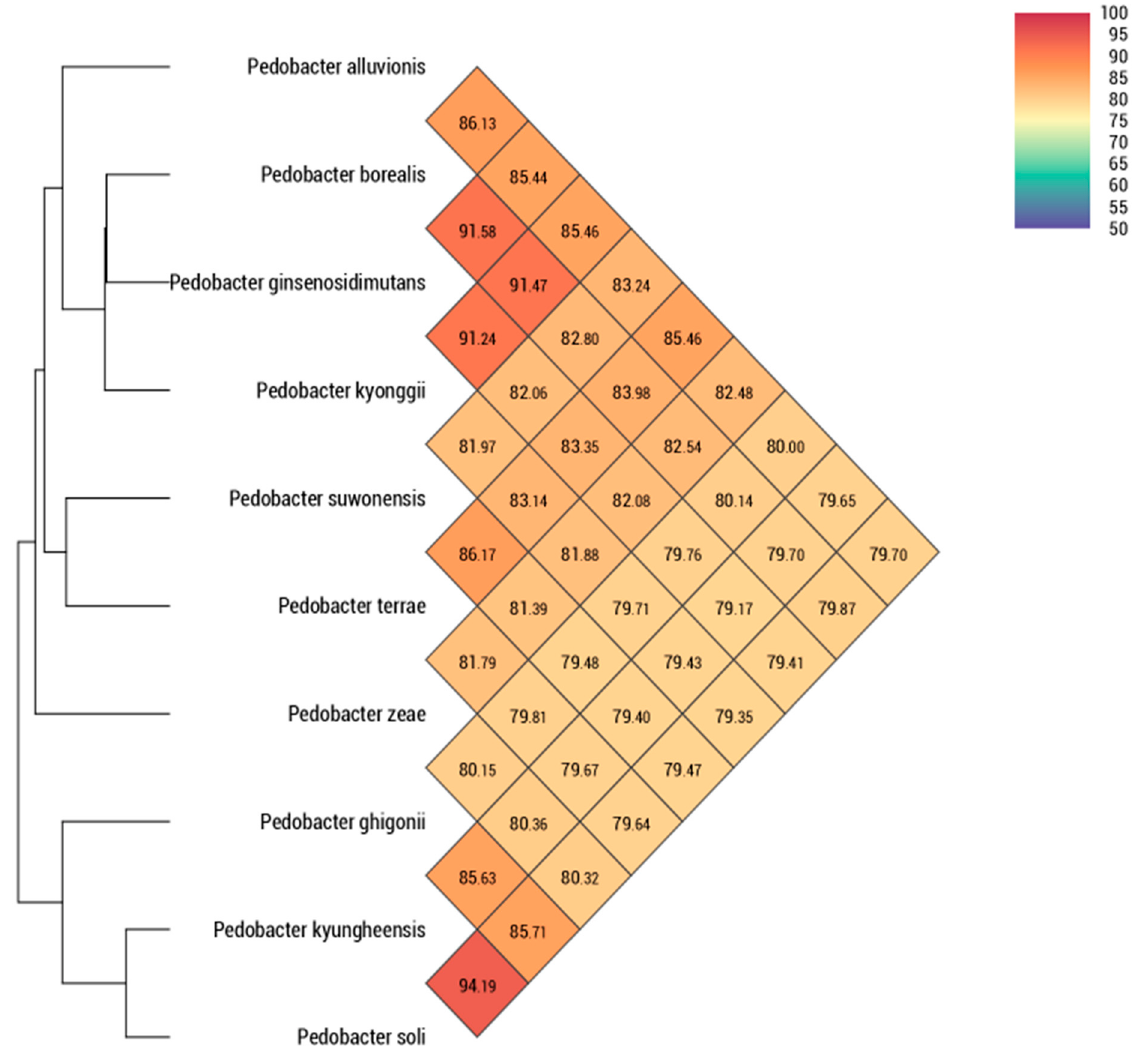
Figure 2. Heatmap generated with Orthologous Average Nucleotide Identity (Ortho-ANI)values calculated using the OAT software, comparing Pedobacter ghigonii and other closely related species with standing in the nomenclature. The color code indicates the closest species with green and the farthest with red. The strain Marseille-Q2390 is mainly grouped with the genus Pedobacter soli and, with less similarity, Pedobacter kyungheensis [19].